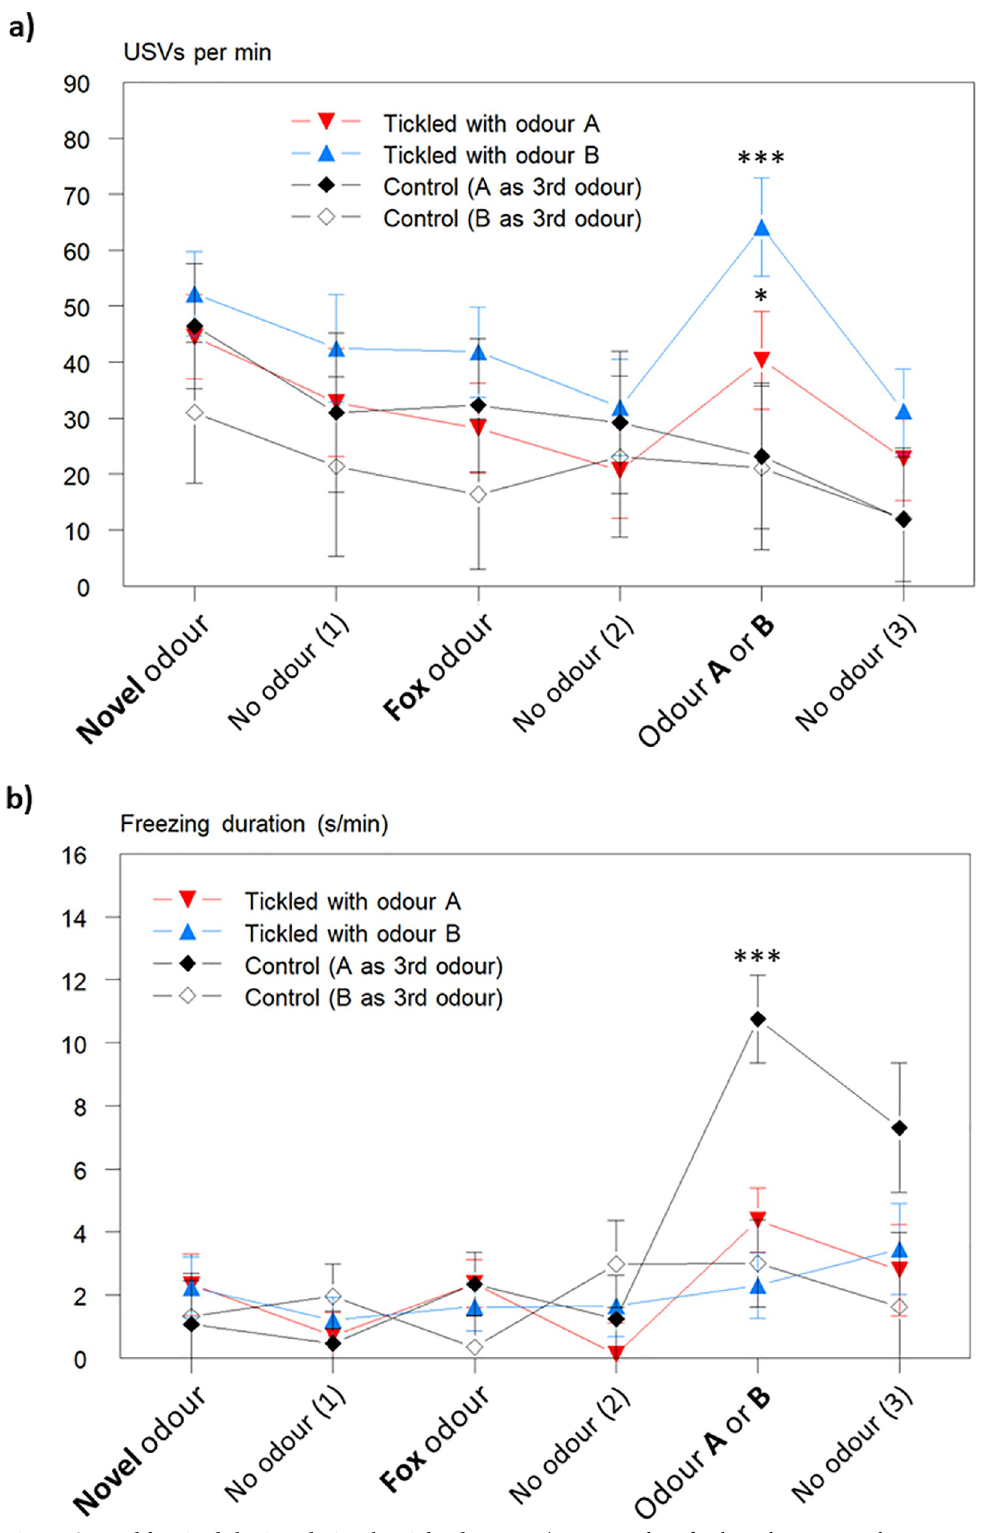
Fig 4. USVs and freezing behaviour during the triple odour test. a) Mean number of 50 kHz ultrasonic vocalisations (USVs; ± s.e.) per minute, and b) mean duration (s; ± s.e.) of freezing behaviour during the Triple Odour test for